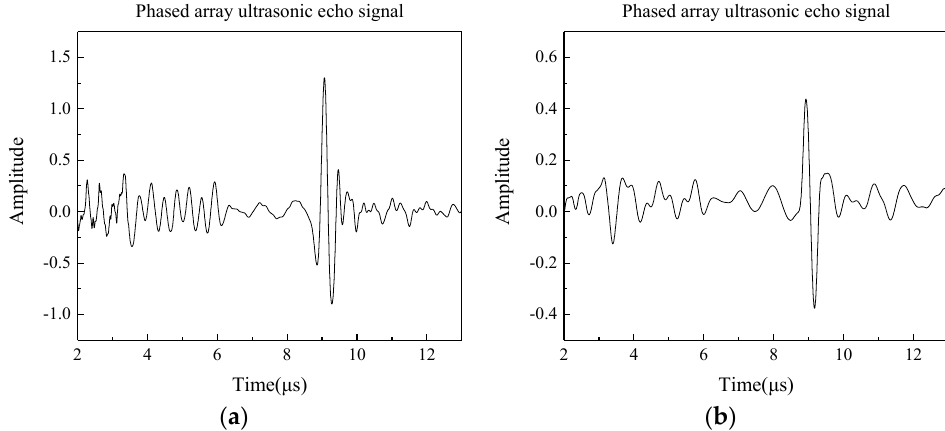
Figure 5. PA longitudinal wave signal of the defect simulated using ( a ) the fast FEM code and ( b ) commercial finite element software.